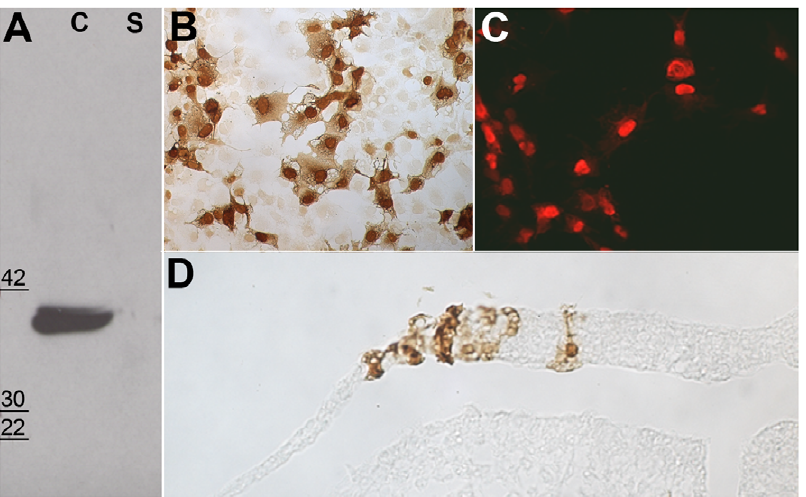
Figure 2. Obelix is intracellular and localizes to the nucleus. A. Obelix protein can be retrieved from cell extracts (C) but not from the supernatant (S) of transfected COS-1 cells, and detected by Western blotting. B–D. Nuclear localization of Myc-tagged Obelix protein can be seen in transfected COS-1 cells (B, C) as well as in the neural plate of a chick embryo (D). In B and D the anti-Myc antibody is revealed by peroxidase staining with diaminobenzidine; in C the signal is revealed with Cy3-coupled anti-mouse